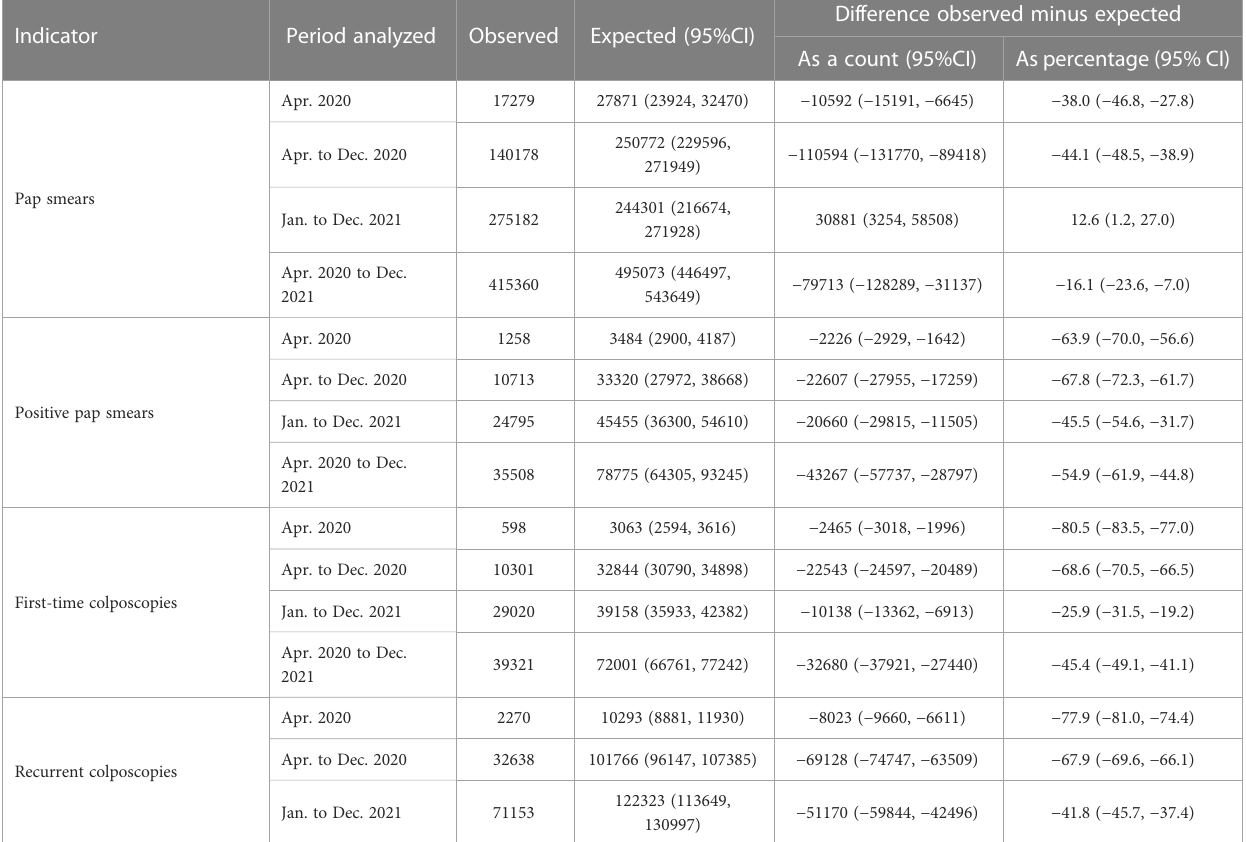
TABLE 2 Estimation of changes in secondary prevention services and CC hospital discharges in the pandemic period with respect to pre-pandemic projected trends.